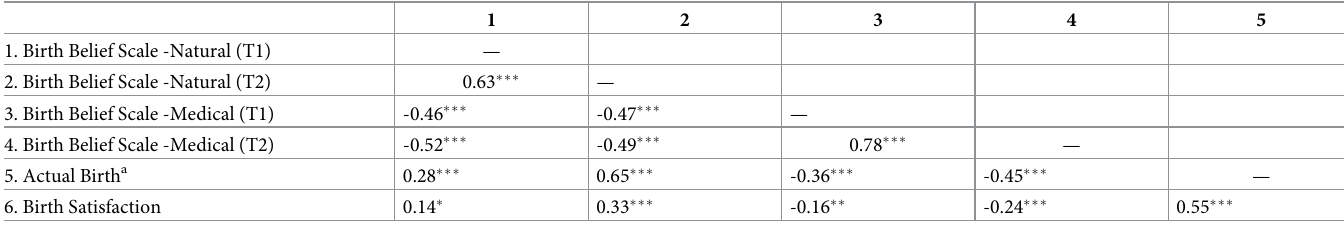
Table 3. Intercorrelations among the study variables.